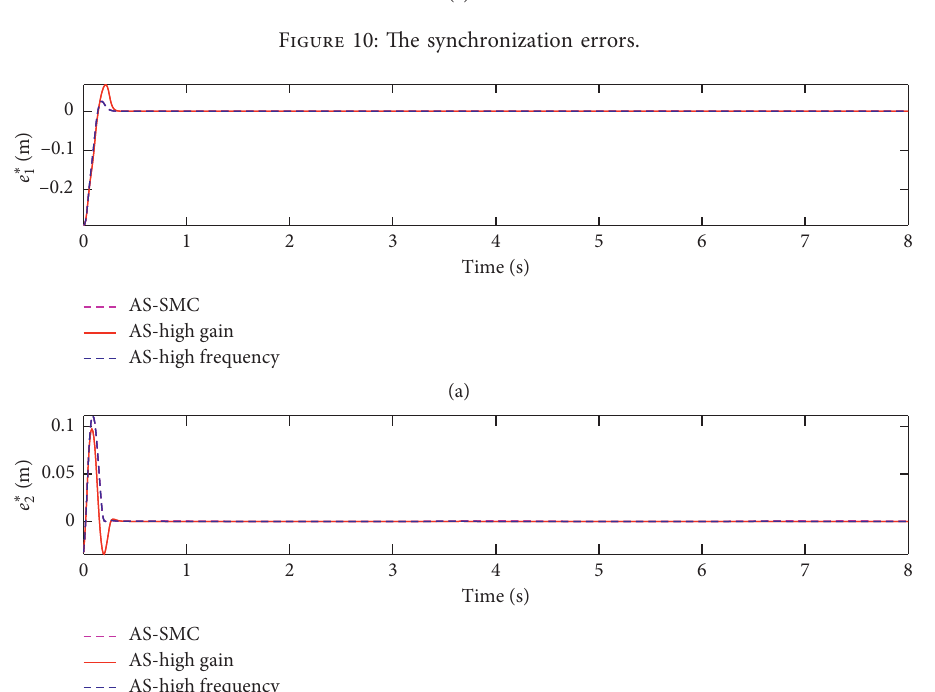
Figure 10: The synchronization errors.